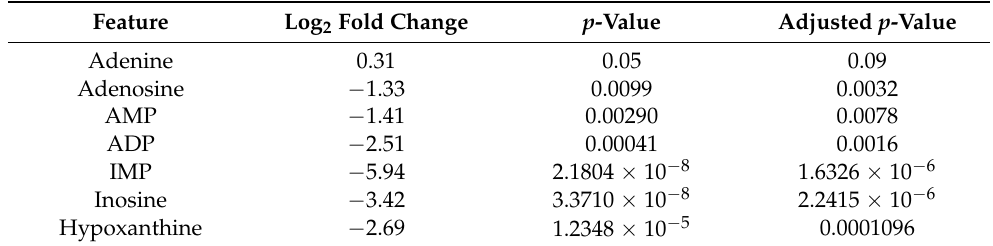
Figure 10. Portion of nucleotide metabolism pathway around adenine metabolism—green is down-regulated and red is up-regulated. Table 1. Fold changes and p -values of significantly changing features in the nucleotide metabolism pathway 24 h post exposure.